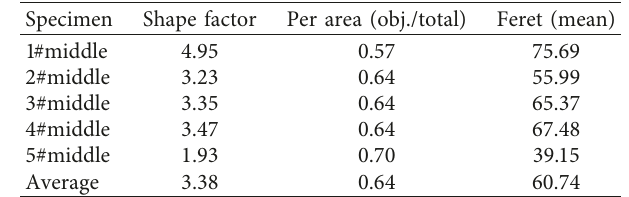
Table 4: Pore structure parameters of the aerated concrete block (top).